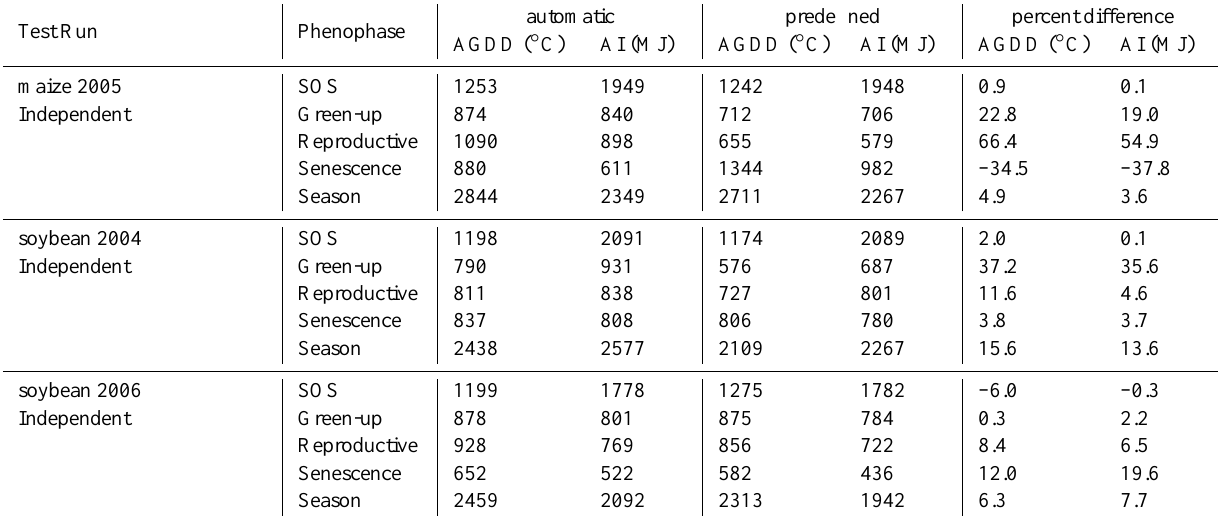
Table A1. Values of phenophase controlling variables observed at automatically estimated phenological transition points (PTPs) com- pared with the corresponding values observed at predefined PTPs considered as the reference. AGDD = accumulated growing degree-days, AI = accumulated insolation, percent difference =